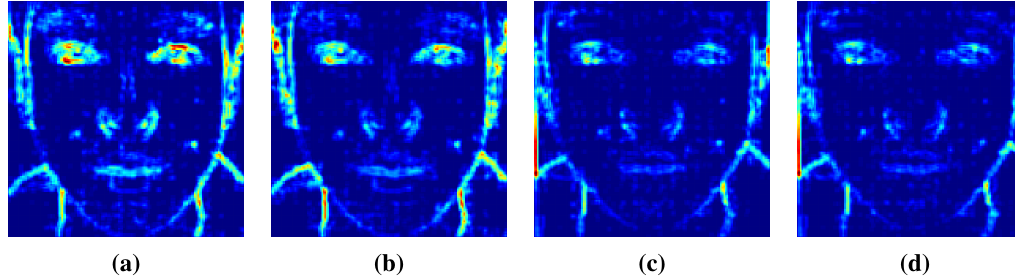
Figure 8. Modified Laplacians (LAPMs) of real face images focused on ( a ) the nose and ( b ) the ear, and LAPMs of fake face images focused on ( c ) the nose and ( d ) the ear. In order to maximize the LAPM difference between regions of the nose and ears, we subtract LAPM − LAPM from LAPM (= LAPM ). To analyze the differences in LAPMs (DiF, difference in focus N N E measures) in a single dimension, we add all of the DiF in the same column. In Figure 9, blue lines